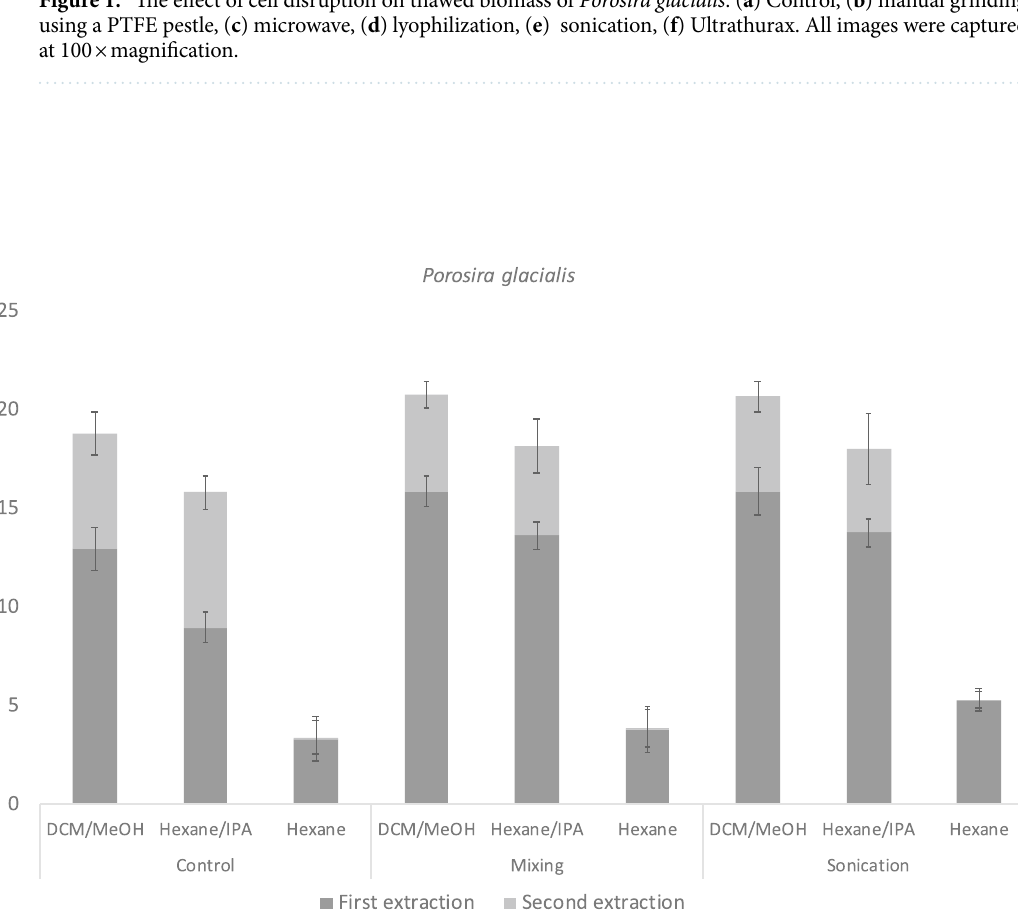
Figure 2. Lipid yields as percent of AFDW (Ash-free dry weight) from Porosira glacialis using three solvent systems; dichloromethane/methanol (2:1 v/v); DCM/MeOH), Hexane/isopropanol (2:1 v/v; Hexane/IPA) and hexane; and three cell disruption treatments; no treatment (control), shaking at 1000 RPM for 60 min (mixing) and sonication at 20 kHz for 10 min (sonication). Two consecutive extractions were performed, data shown is the arithmetic mean of each extraction, n = 5. The error bars represent the standard deviation of the mean for the first extraction (bottom bar) and for the total yield (top